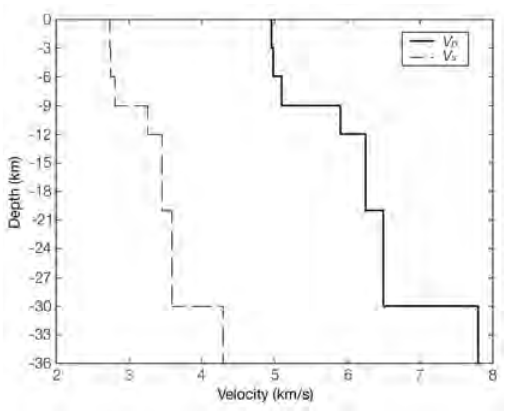
Fig. 5. Local velocity model.